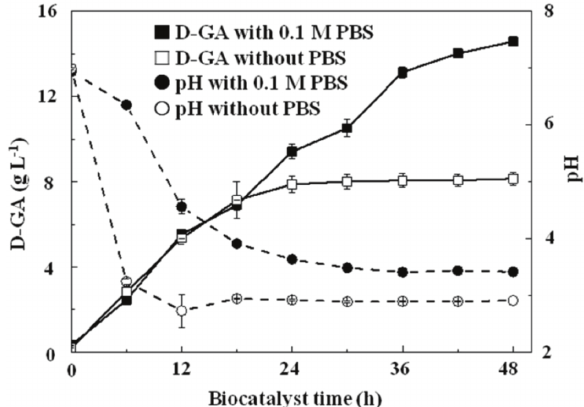
Fig. 4 – Effect of pH buffer on D-GA biosynthesis and pH in